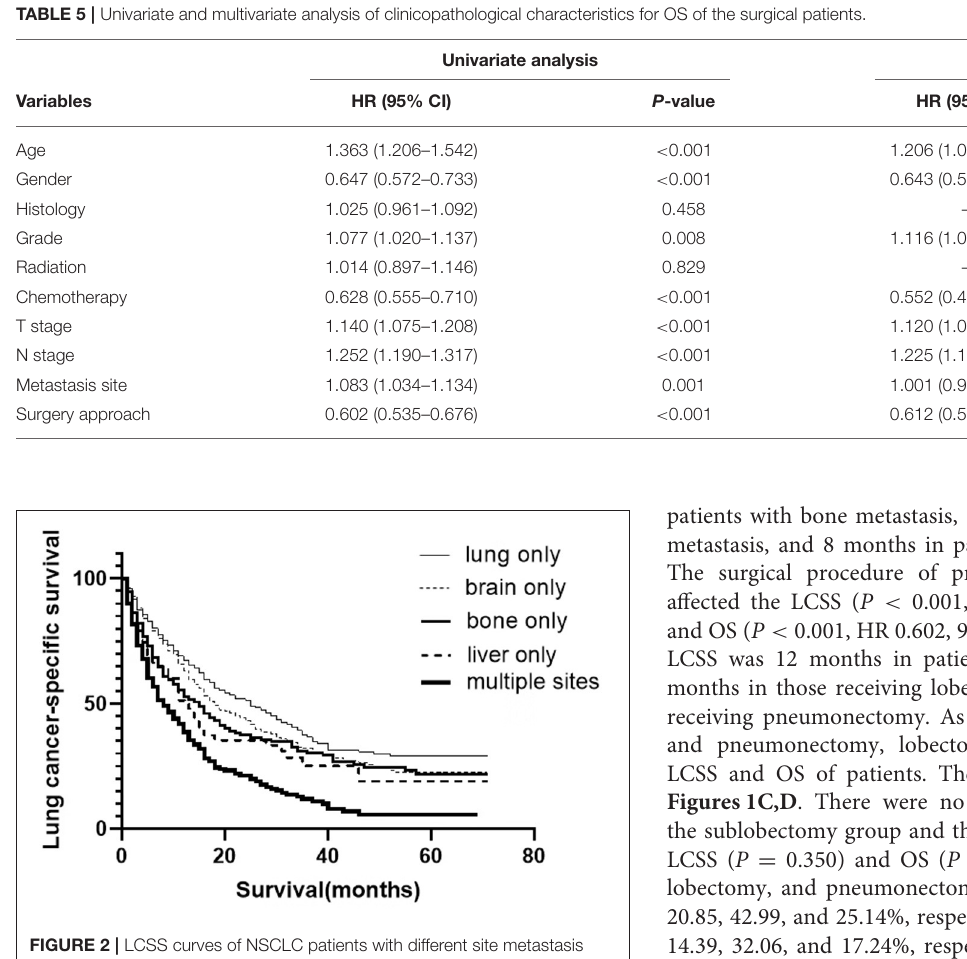
patients with multiple metastasis had the worst survival. The median LCSS was 25 months in patients with lung